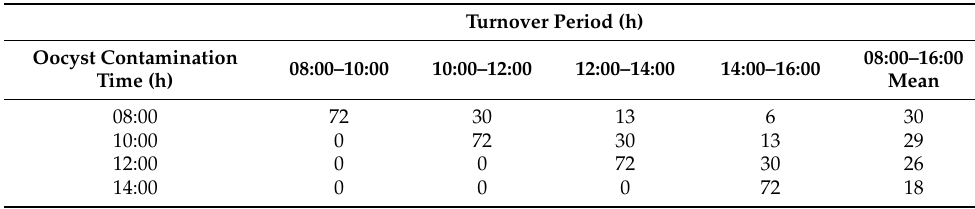
Table 6. Average expected concentration of oocysts (expressed as a percentage of the initial peak) during each successive turnover period during the course of a day, depending on just when the contamination occurred, for a pool with a two hour turnover